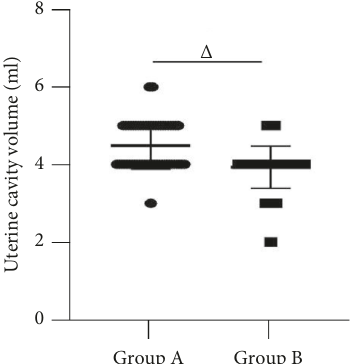
Figure 7: Uterine cavity volume. Note . Δ indicates P < 0 . 05 for the difference between groups A and B.